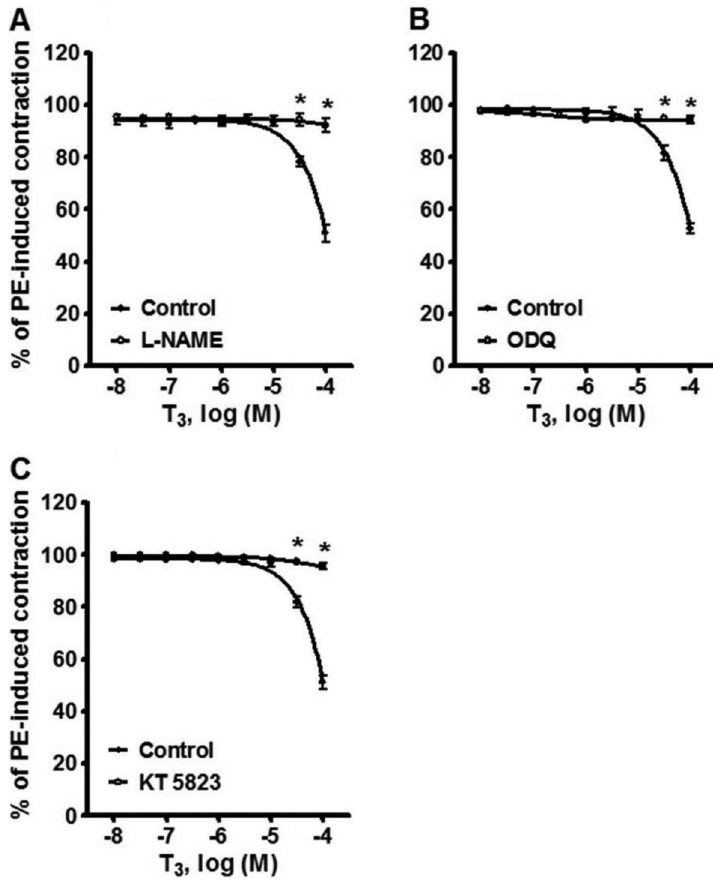
Figure 3. Vasorelaxation produced by 10 -8 – 10 -4 M T 3 in phenylephrine (PE)-precontracted rat aortic rings. Assays were carried out to test the effect of: A , 10 -5 M L-NG-nitroarginine methyl ester (L-NAME), B , 10 -7 M 1H-(1,2,4)oxadiazolo[4,3-a]quinoxalin-1-one (ODQ), and C, 10 -6 M (9 S ,10 R , 12 R )-2,3,9,10,11,12- hexahydro-10-methoxy-2,9-dimethyl-1-oxo-9,12- epoxy-1 H -diindolo[1,2,3- fg :3 0 ,2 0 ,1 0 - kl ]pyrrolo[3,4- i ](1,6) benzodiazocine-10-carboxylicacid,methylester(KT 5823). Data are reported as means ± SE (n=8). *P o 0.05 vs control (two-way